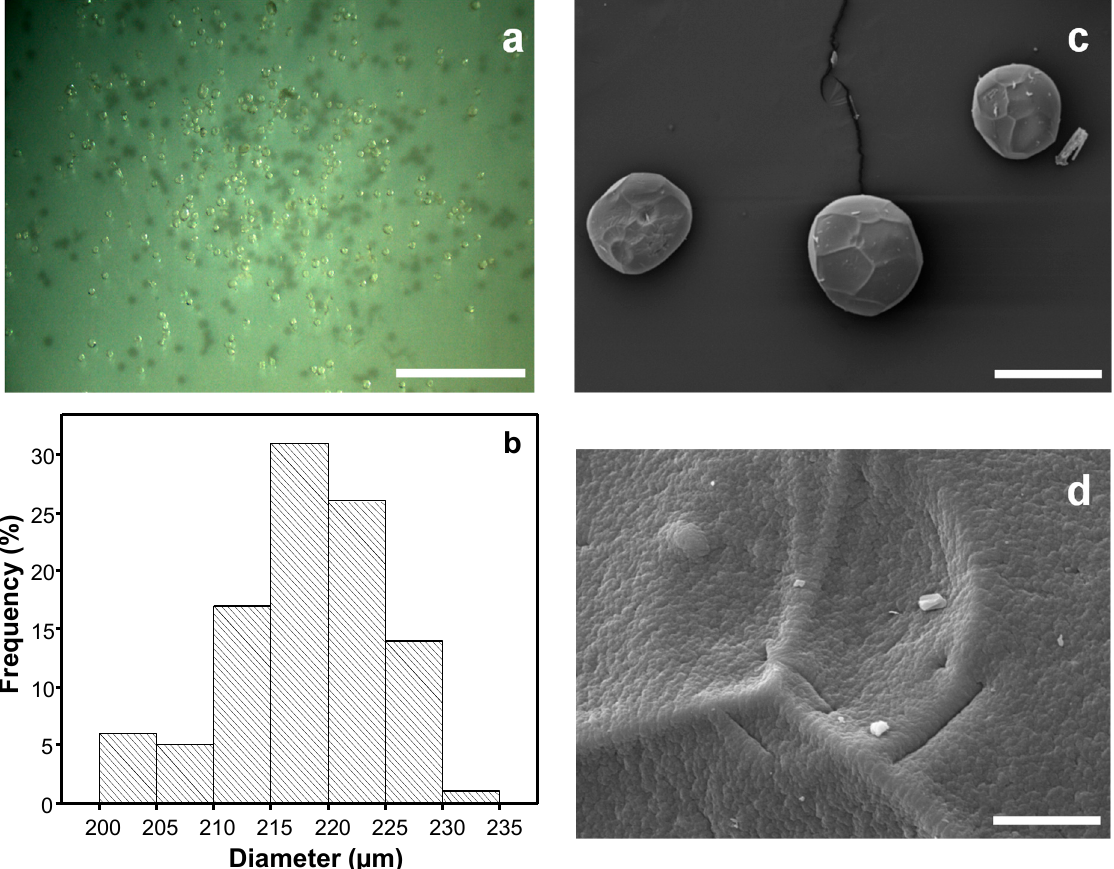
Figure 6. ( a ) Optical micrograph and ( b ) size distribution (mean width: 217.49 ± 6.34 µ m) of alginate microparticles obtained by drop-on-demand inkjet technology (4% (w / v) alginate, 0.2 M CaCl 2 bath with 0.2 M NaCl, 1 h hardening time). ( c , d ) SEM micrographs of the alginate microparticles at di ff erent magnifications. Scale bars: ( a ) 2 mm, ( c ) 200 µ m, ( d ) 8 µ